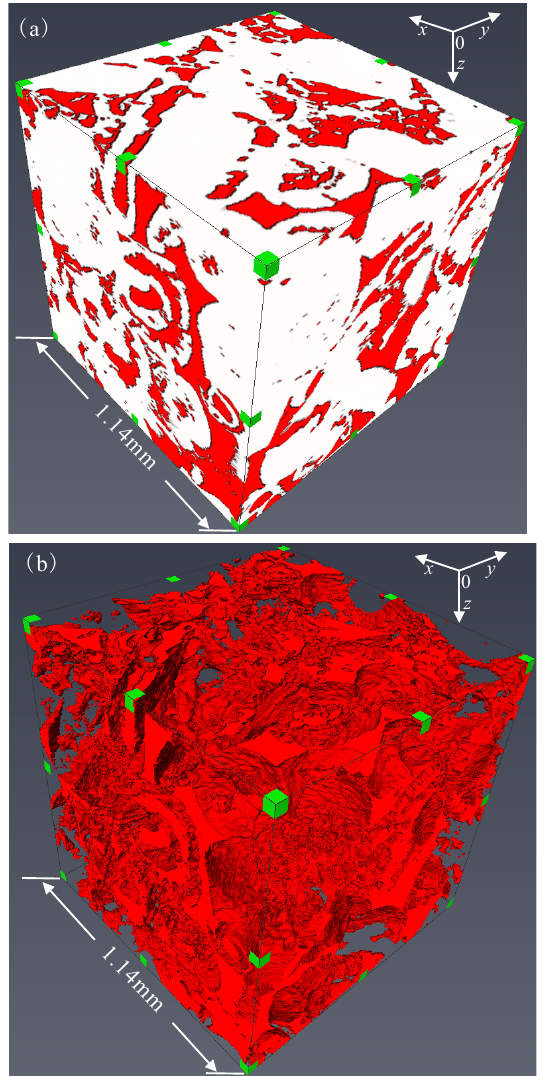
Figure 9. Carbonate digital rock C1 [50]. The size of the digital rock is 400 3 grids and the length of a grid is 2.85 μ m in three directions. The porosity is 23.3%. ( a ) The schematic of micro CT image of C1; and ( b ) Pore space distribution of C1.